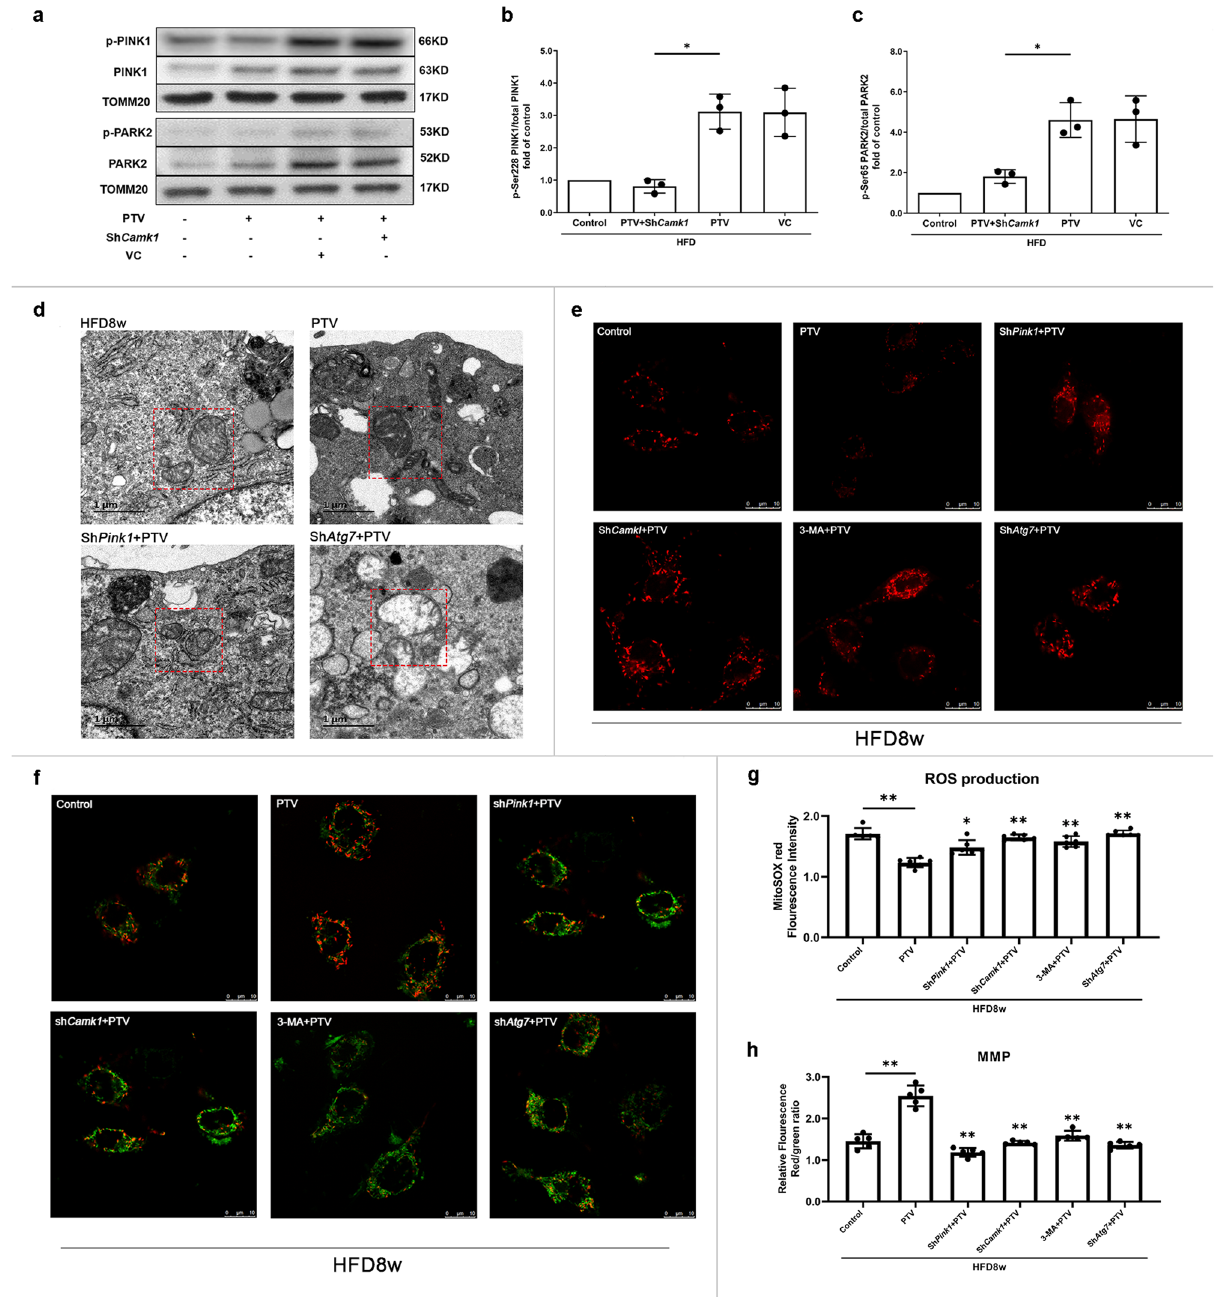
Fig. 8 CAMK1 contributes to phosphorylation of PINK1 and PARK2 to PTV-induced mitophagy. EPCs were stably transfected with Camk1 knockdown lentiviral vector 72 h before 0.5 μ m PTV treatment for 24 h. a Immunoblot was employed to detect phosphorylation of PINK1 Ser 228 and PARK2 Ser 65 in each group. We normalized the expression of total PINK1 or PARK2 to compare the phosphorylation level. b Quantitative analysis revealed that PTV signi fi cantly up-regulated Ser 228 phosphorylation in PINK1 but Camk1 knockdown remarkably reduced this effect in PECs from atherosclerotic mice. c Quantitative analysis revealed that PTV signi fi cantly increased PARK2 Ser 65 phosphorylation but Camk1 knockdown reversed this effect in PECs from atherosclerotic mice. d PTV treatment reversed HFD8w-induced mitochondrial swelling and rupture of mitochondrial cristae; either PINK1 or ATG7 silencing blocked the effect of PTV on mitochondria of EPCs. e PTV treatment reversed HFD8w-induced ROS production, scale bar: 10 μ m. f PTV treatment reversed HFD 8w-induced MMP decreased, scale bar: 10 μ m. Quantitative analysis indicated the effect of PTV on ROS ( g ) and MMP ( h ) of EPCs can be inhibited by silencing ATG7, PINK1 blocked, and 3-MA pretreatment. (EPCs were isolated from 3 ApoE − / − mice fed with high fat diet for 8 weeks and 3 independent experiments were performed, mean ± SD, * P < 0.05, ** P <